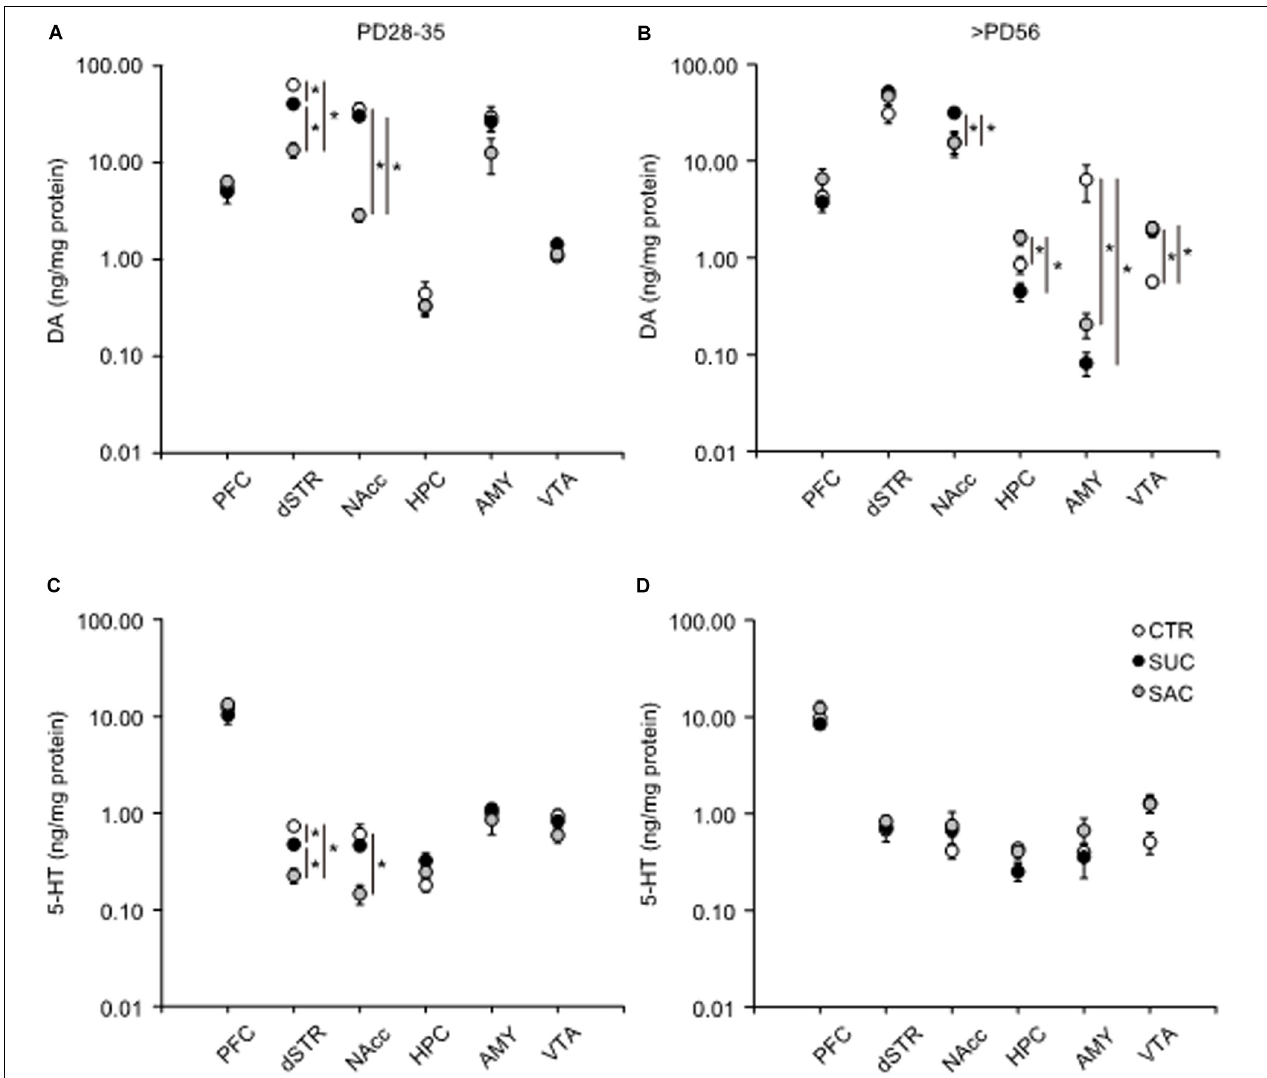
FIGURE 3 | Alterations of tissue DA and 5-HT concentrations in mesocorticolimbic regions of animals subjected to sucrose and saccharine treatments. Graphs showing tissue DA concentrations in the PFC, dSTR, NAcc, HPC, AMY, and VTA of juvenile (A) and adult (B) animals. Graphs similar to a and b but showing tissue 5-HT concentrations in juvenile (C) and adult (D) animals. * p < 0.05.